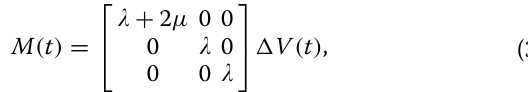
 ( t ) = (cid:31) where and µ are the Lamé constants and � V ( t ) is the time history of the volume change of the crack (e.g., Aki and Richards 2002). The volume change for a rectangular tensile crack is expressed as